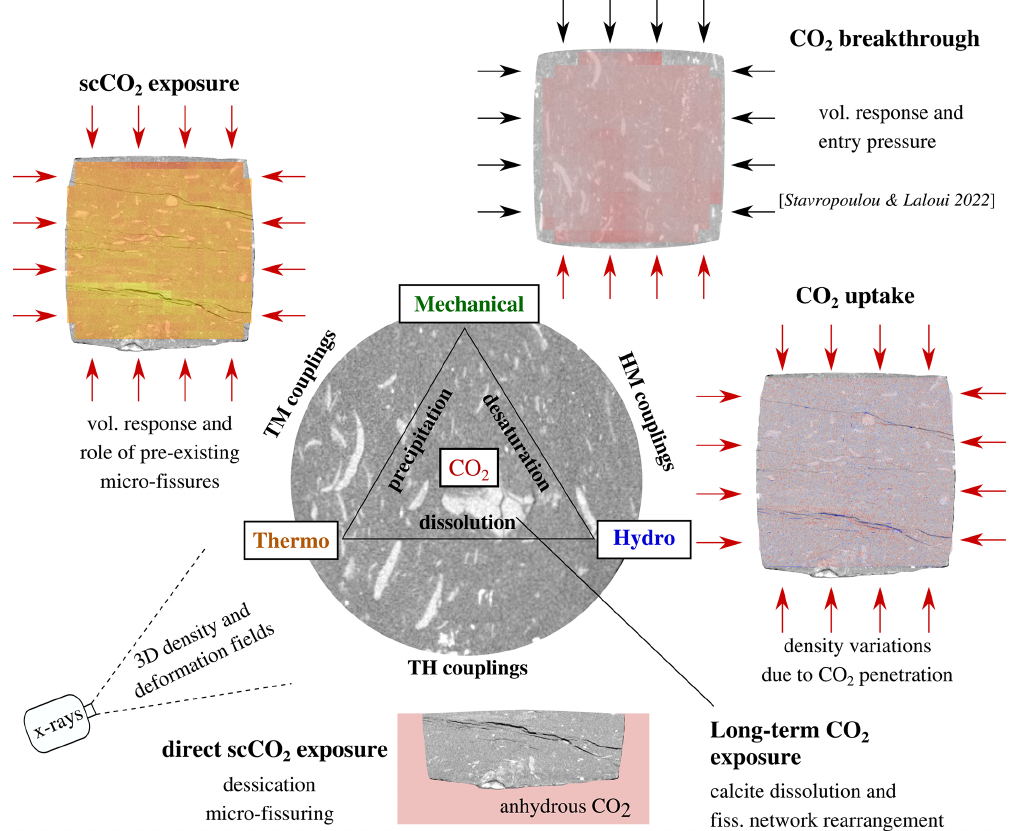
Figure 10. Coupled THCM mechanisms studied with in situ X-ray imaging on small-sized shale